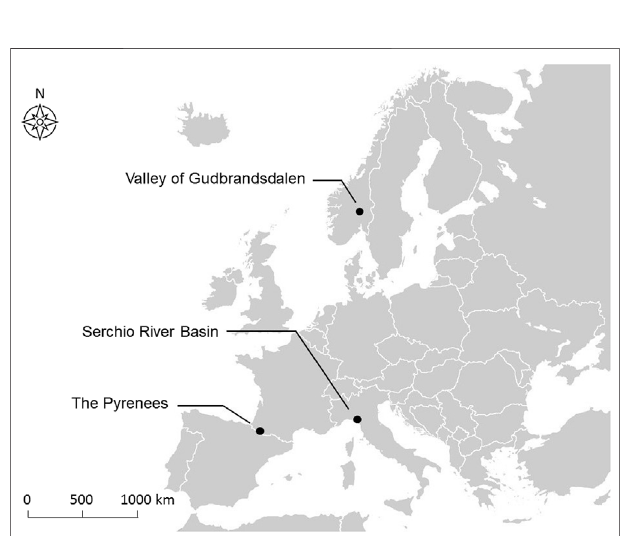
FIGURE 1 | Flow chart on the search strategy and analysis for the literature review.